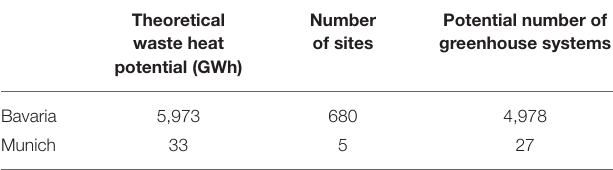
TABLE 2 | Number of possible greenhouse systems. TABLE 3 | Water footprint comparison (Source: The Water Footprint Network,